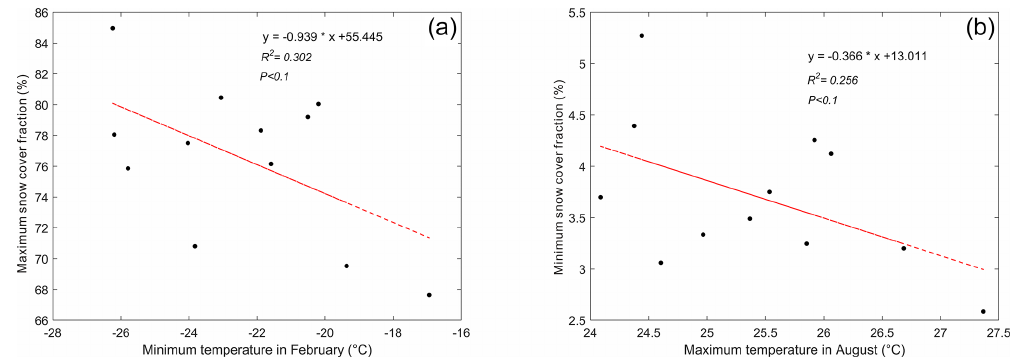
Figure 8. Relationship of temperature and snow cover fraction (a) minimum temperature in February vs. maximum snow cover fraction and (b) maximum temperature in August vs. minimum snow cover fraction from 2002 to 2013.